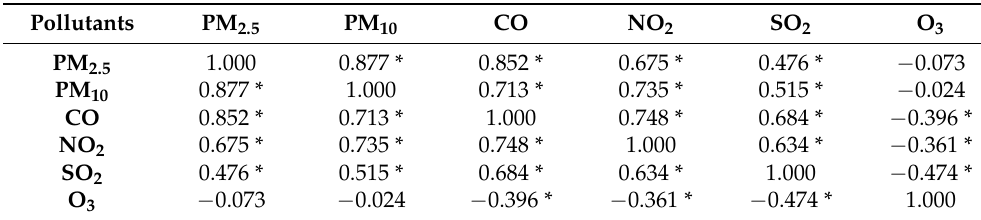
Int. J. Environ. Res. Public Health 2017 , 14 , x; doi: FOR PEER REVIEW